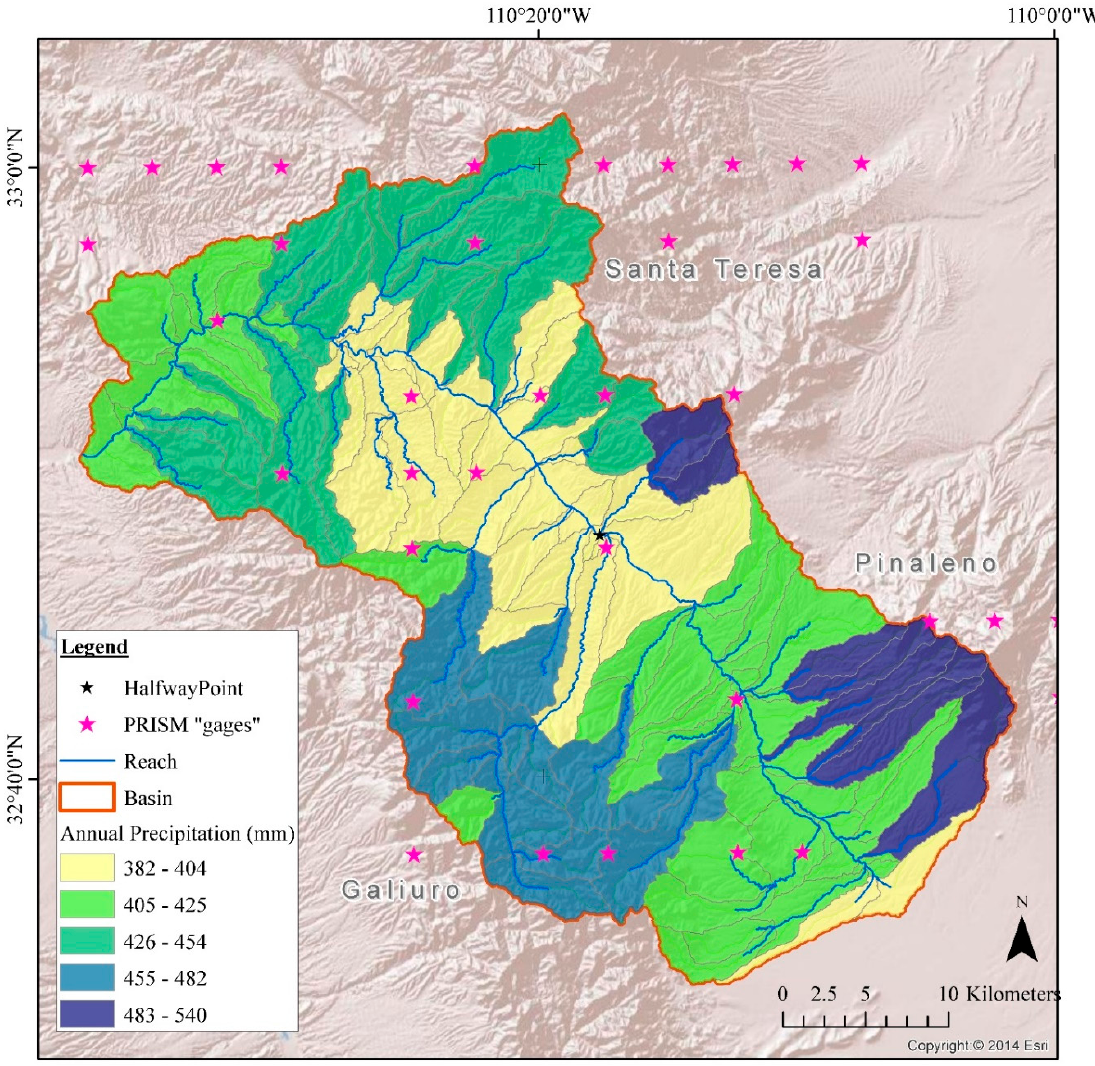
Figure 4. Distribution of precipitation based on synthesized gage dataset to represent daily rainfall summarized to 2016 annual